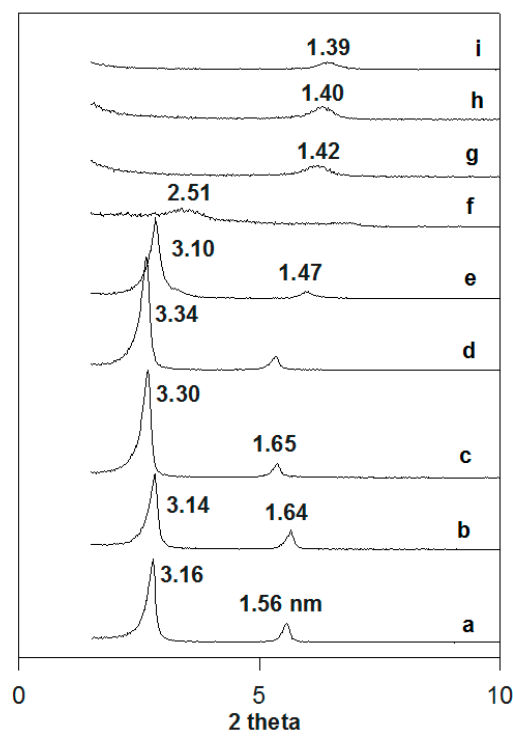
Figure 9. In situ powder XRD patterns of ( a ) C16Mag-80 preheated at different temperatures: ( b ) 50 °C, ( c ) 100 °C, ( d ) 150 °C, ( e ) 200 °C, ( f ) 215 °C, ( g ) 250 °C, ( h ) 300 °C, and ( i ) 400 °C.